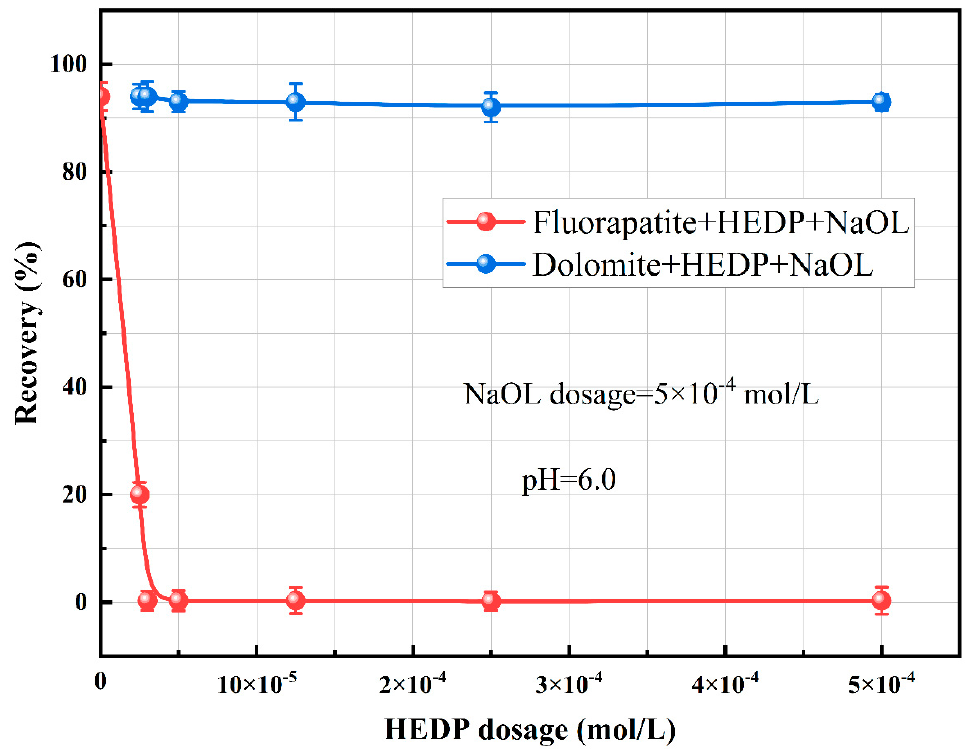
Figure 4. Influence of depressant dosage on the flotation recovery of fluorapatite and dolomite.